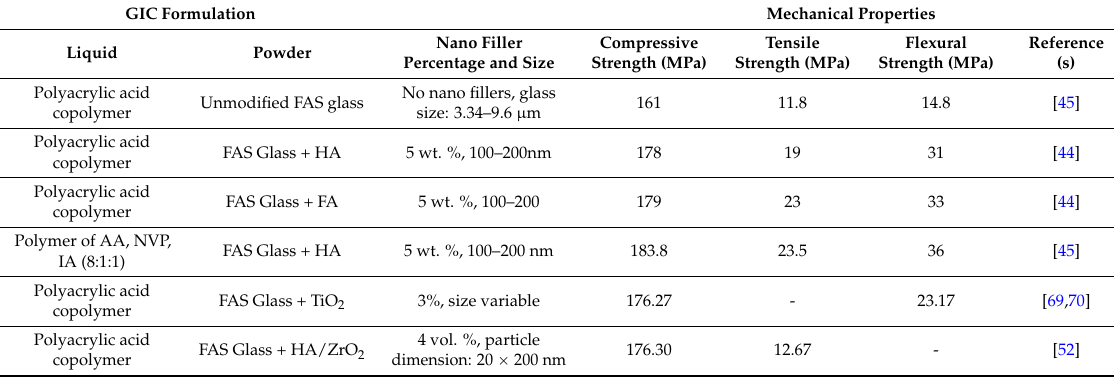
Table 1. Some powder modifications of glass ionomer cements and their reported properties. HA, hydroxyapatite; FA, fluorohydroxyapatite; FAS, fluoroaluminosilicate; TiO 2 , titanium oxide; ZrO 2 , zirconium